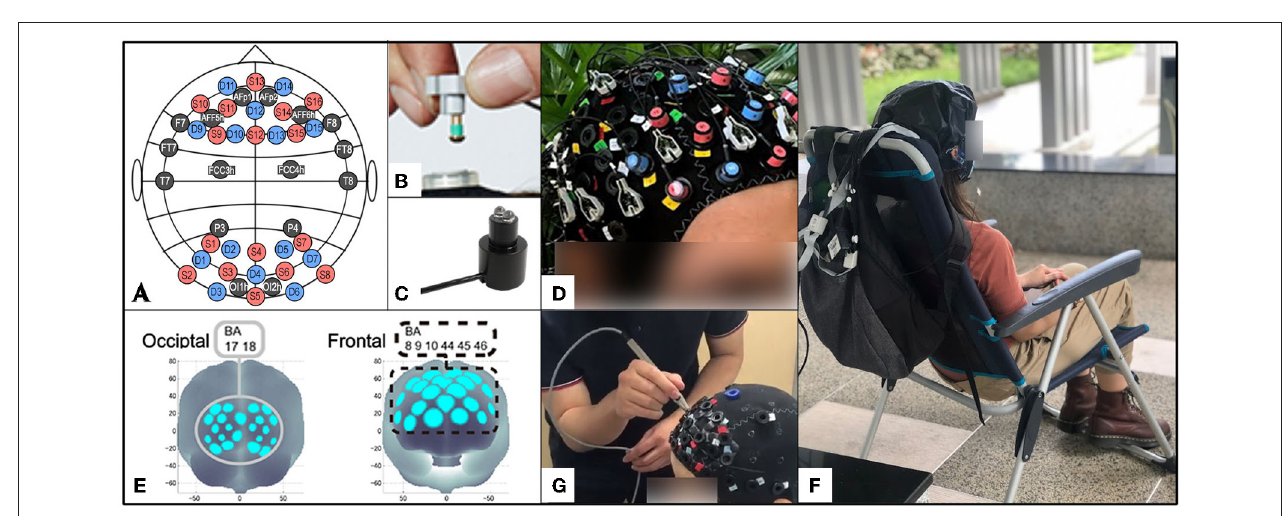
FIGURE 2 | Experimental equipment and setup: (A) montage of the multi-modal system with EEG electrodes marked in black, fNIRS sources (S) with red and detectors (D) with blue; (B) NIRSport optode with a dual-tip; (C) EEG dry active electrode with an adjustable mushroom-head; (D) multi-modal NIRSport/EEG V-amp systems mounted onto one stretchable anti-cap, before the light-blocking over-cap placement; (E) regions of interest for fNIRS analysis according to Brodmanns Area (BA): occipital (BA: 17, 18) and frontal (BA: 8, 9, 10, 44, 45, 46); (F) participant with the brain scanning device mounted on her head, during the passive task; (G) digitization of the probe positions using a 3D-digitizer (Fastscan,